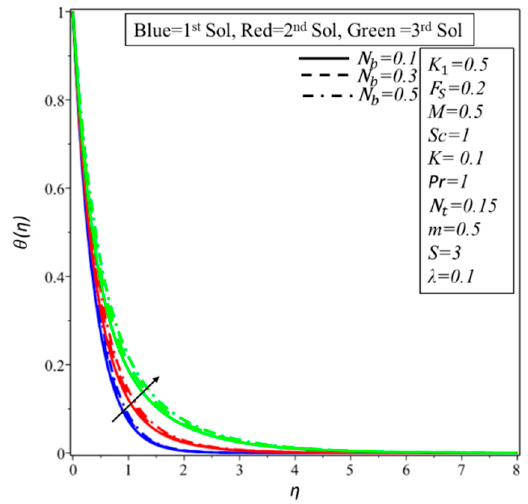
Figure 11. Temperature profiles for increasing values of N b .